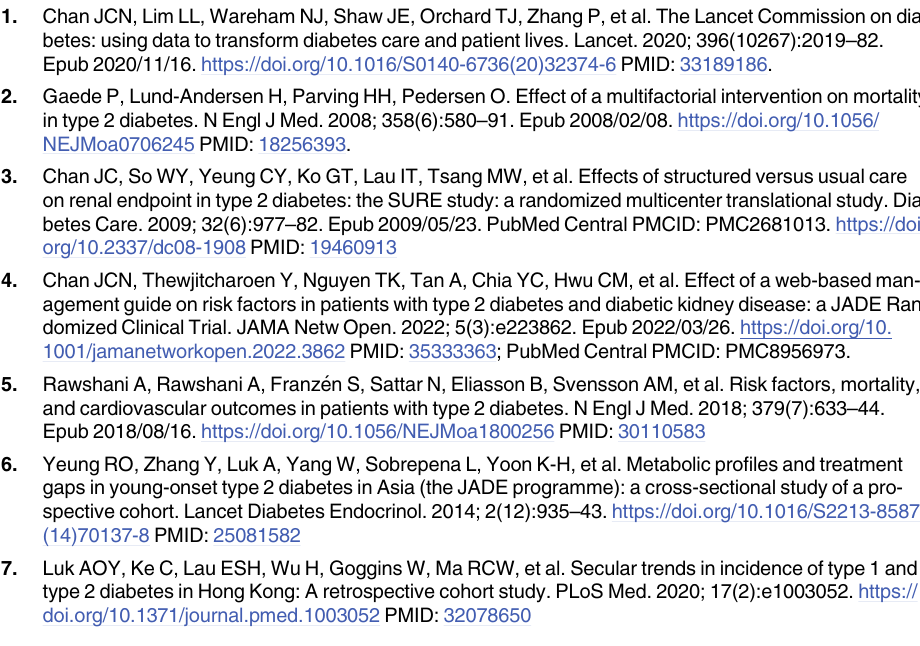
S14 Fig. PAFs of risk factors for cause-specific mortality by age in people with type 2 diabe- tes accounting for competing risks from other causes of